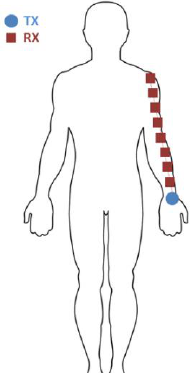
Figure 1. Frontal view of the on-body setup of the reference path-loss measurement scenario. The blue marker indicates the TX location, while the red markers indicate different RX positions.